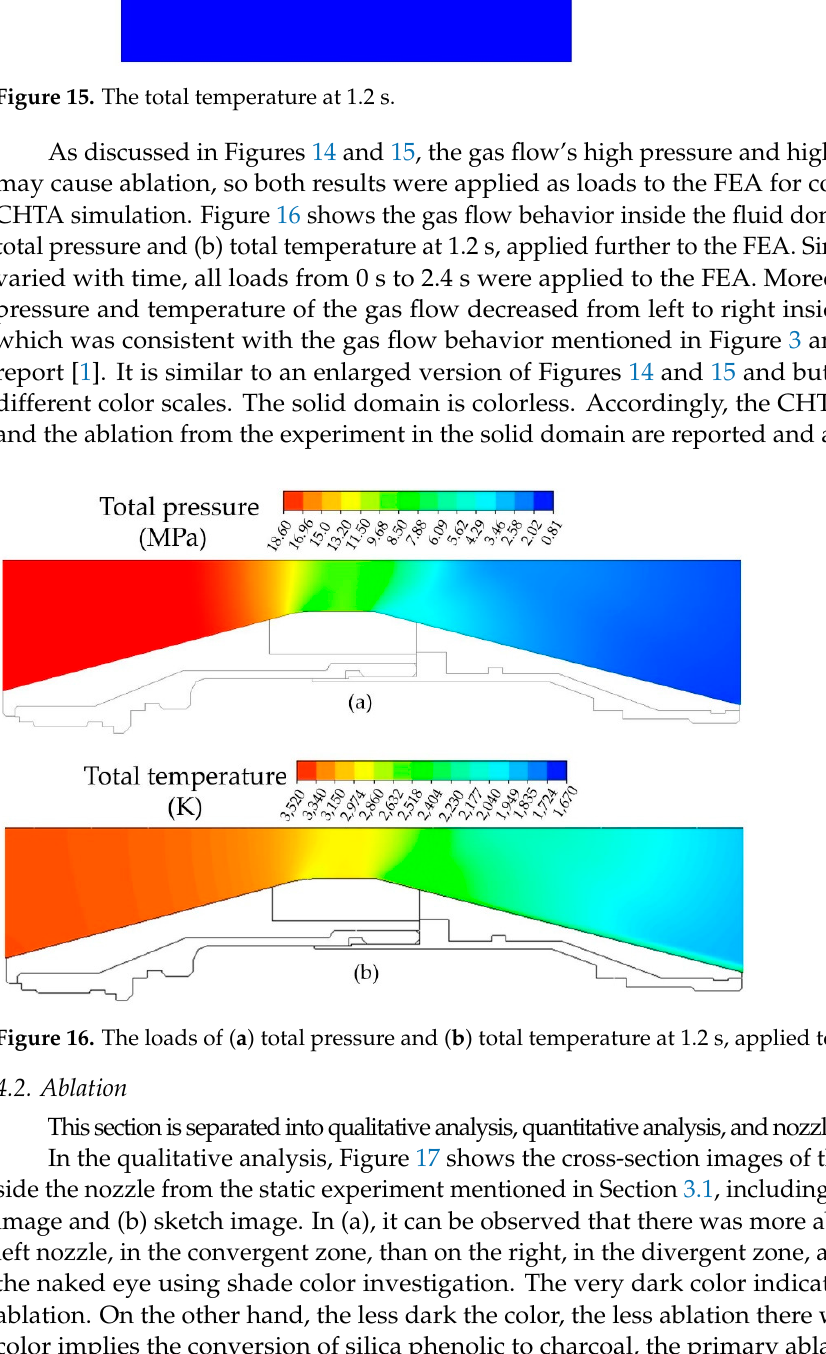
Figure 15. The total temperature at 1.2 s.